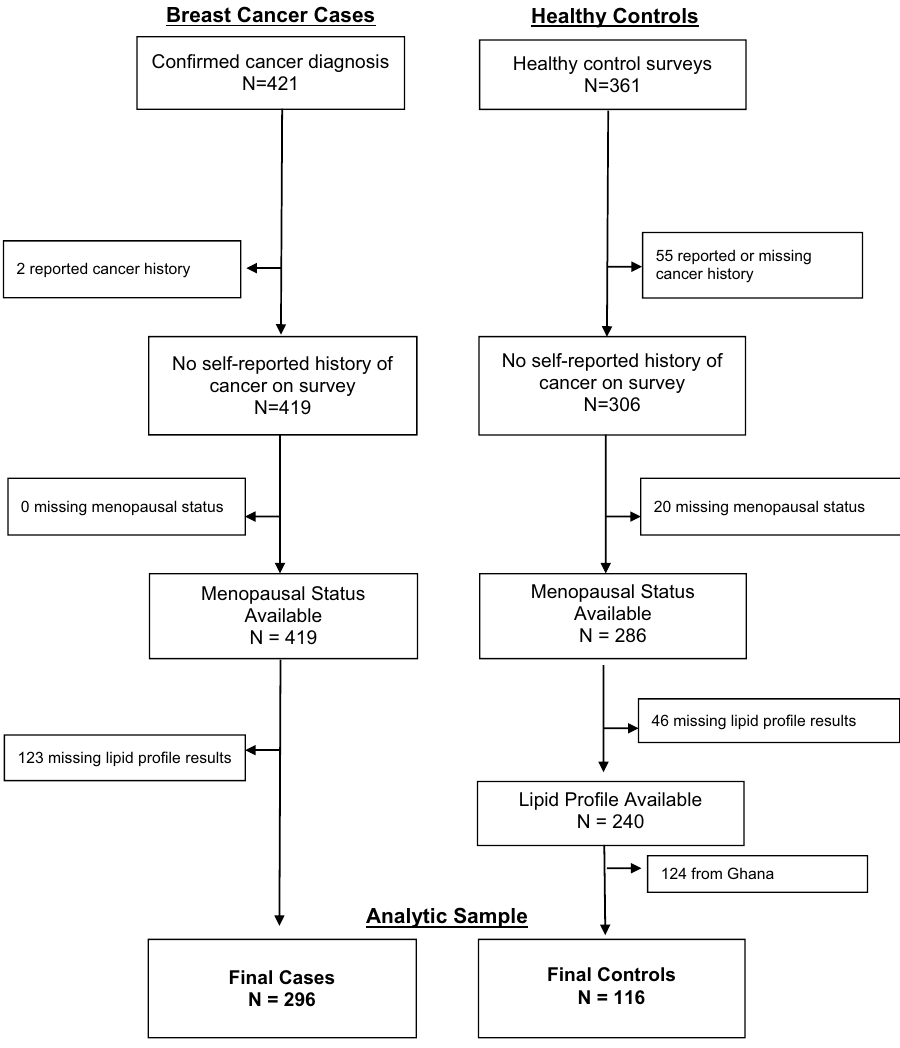
Figure 1. CONSORT diagram for MEND lipid profile